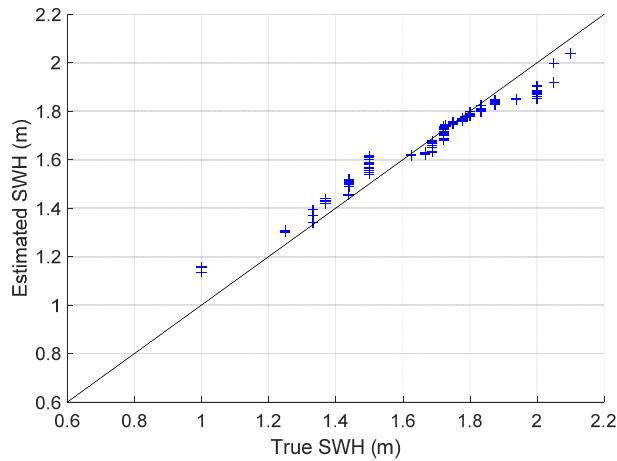
Figure 11. Q-Q plot for GNSS-R-retrieved SWH versus true SWH.